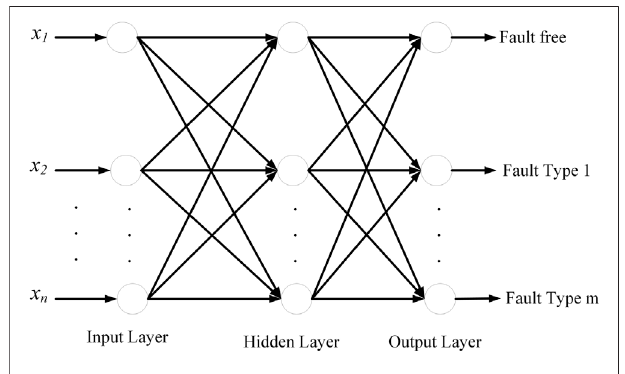
FIGURE 5 | ANN-based WT fault diagnosis